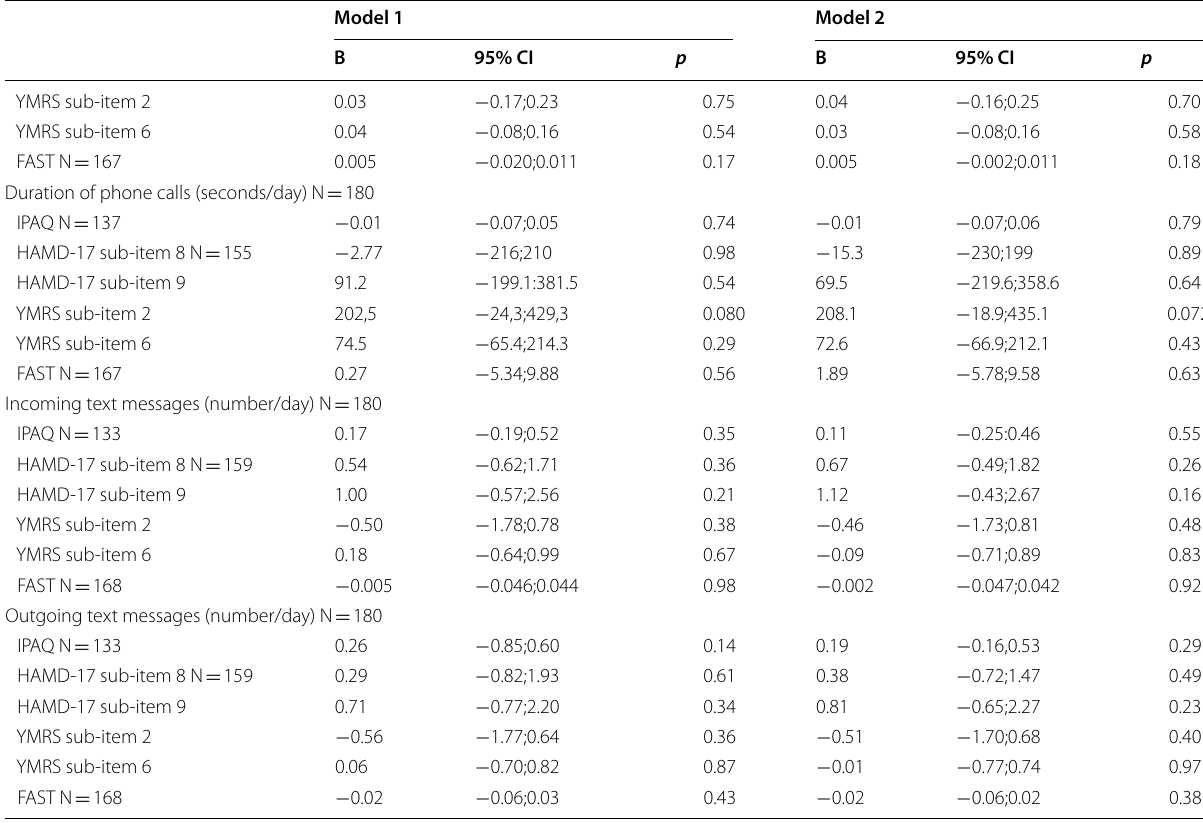
Table 3 Associations between self-reported a and automatically generated b smartphone-based data for all participants in the study owning an Android smartphone